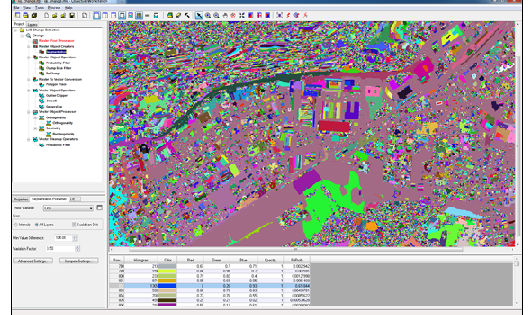
Figure 4. Segmentation results. Note that each segment is attributed with a pixel probability derived from the Probability of Height Increase